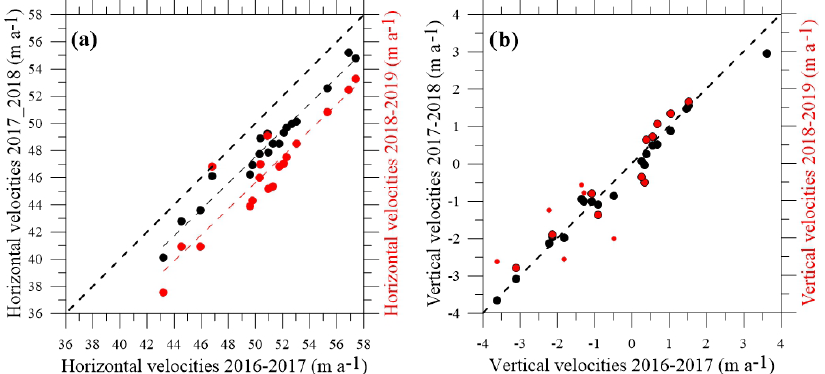
Figure 5. Comparison of horizontal ice flow velocities (a) and vertical velocities (b) between the years 2016/2017, 2017/2018 and 2018/2019. The black dots correspond to the comparison between the 2016/2017and 2017/2018 periods. The red dots correspond to the comparison between the 2016/2017 and 2018/2019 periods. The thick dashed line corresponds to the bisector and the thin dashed lines to the regression lines. The small dots in the figure on the right correspond to the stakes that were set up in 2018 at distances of more than 25m from their initial